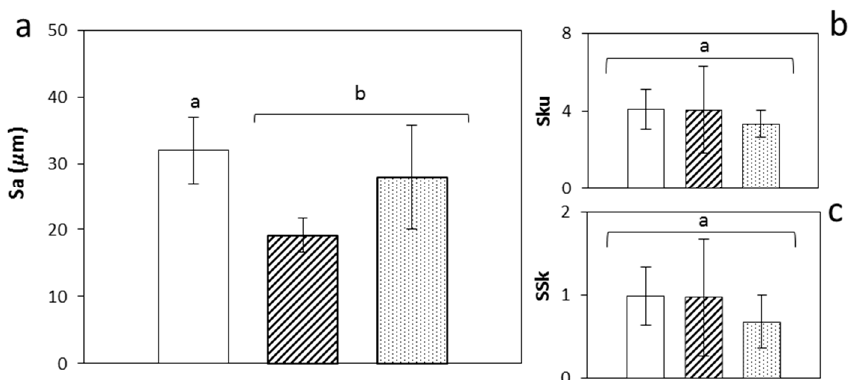
Figure 3. Surface topography of starch aerogels through a contactless 3D ‐ optical profiler. Surface texture parameters: ( a ) arithmetical mean height, ( b ) kurtosis, and ( c ) skewness describing height according ISO 25178. Legend: [Z0] (white bars), [Z1] (black stripes) and [Z2] (black dots). Results were statistically compared (1 way ‐ ANOVA; p < 0.05). Equal letter denotes statistically homogeneous groups.